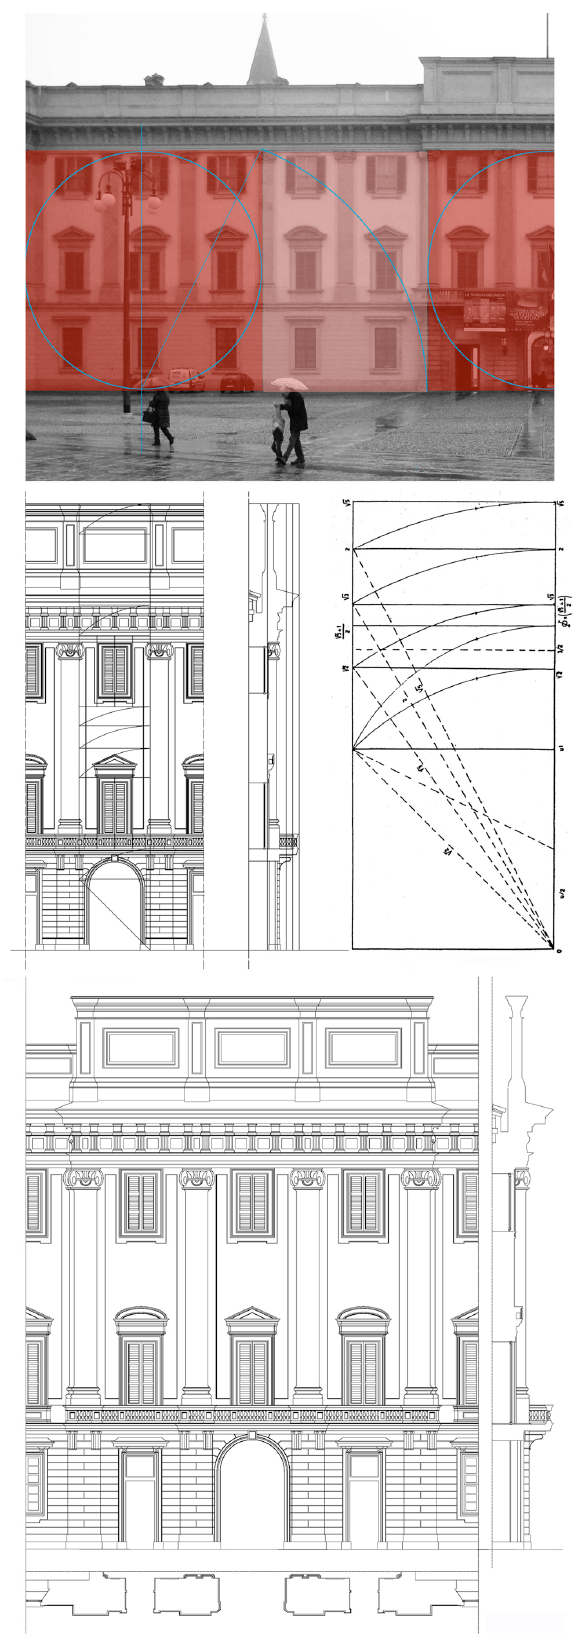
Figure 10 - Royal Palace in Milan, Italy. Architectural survey and proportioning schemes based on tilting the diagonal of the square base and that of successive rectangles. Course of Drawing, Milan Polytechnic (De Masi,